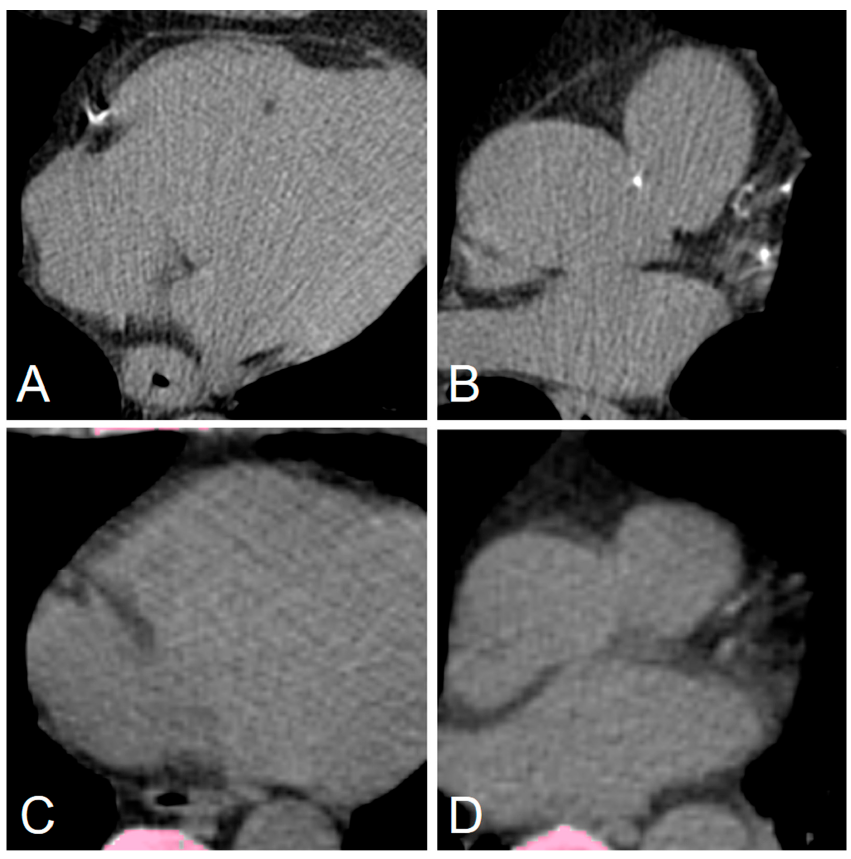
Figure 4. Representative false negative markings from the AI-CACS tool on ungated CT from PET/CT in a 73-year-old man undergoing PET/CT. Dedicated gated coronary calcium scan showed small coronary calcifications in the right coronary artery ( A ) and left anterior descending as well as left circumflex artery ( B ). However, the calcifications are not depicted on ungated low dose PET/CT ( C , D ) performed for staging of lung cancer.